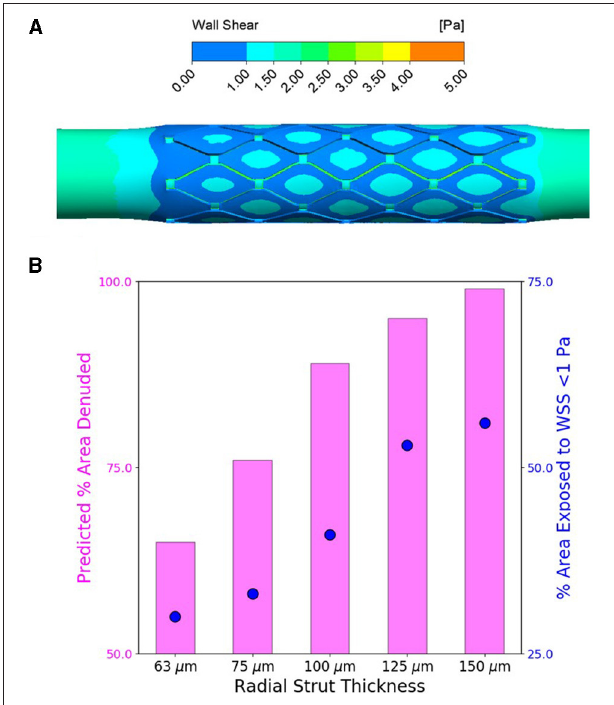
FIGURE 5 | Increasing stent strut thickness increases predicted arterial luminal surface area exposed to the threshold hoop stress for endothelial denudation and also predicted area exposed to wall shear stress (WSS) < 1Pa. (A) Computational fluid dynamics (CFD) representative WSS contour map for flow through slotted tube (radial strut thickness of 125 µ m)-stented artery. (B) Percent of arterial luminal area exposed to WSS < 1Pa (shown in blue) for increasing strut thickness compared to percent of area likely to be denuded from finite element analysis (FEA) predictions (shown in pink) for increasing strut